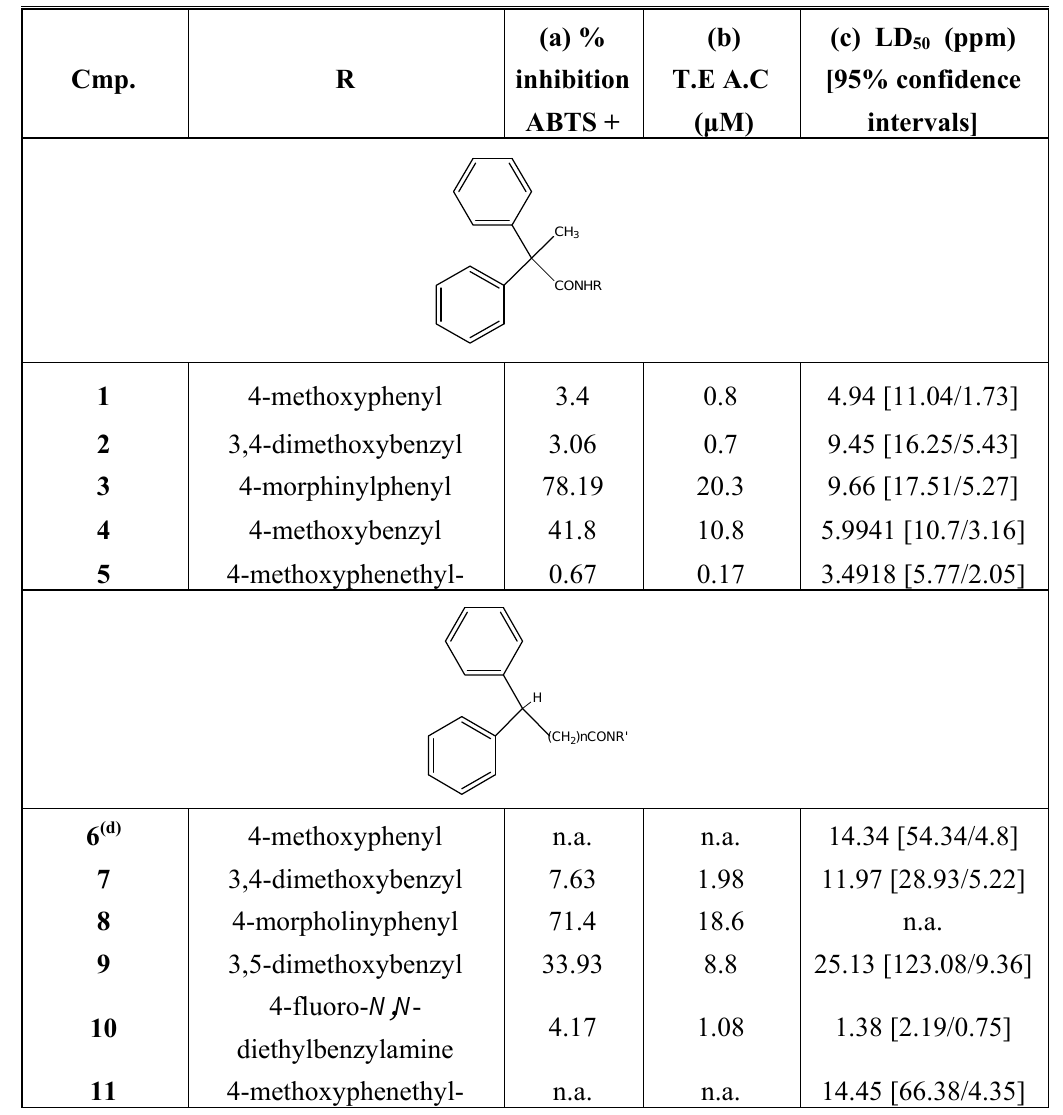
Table 1 . Biological activities of samples